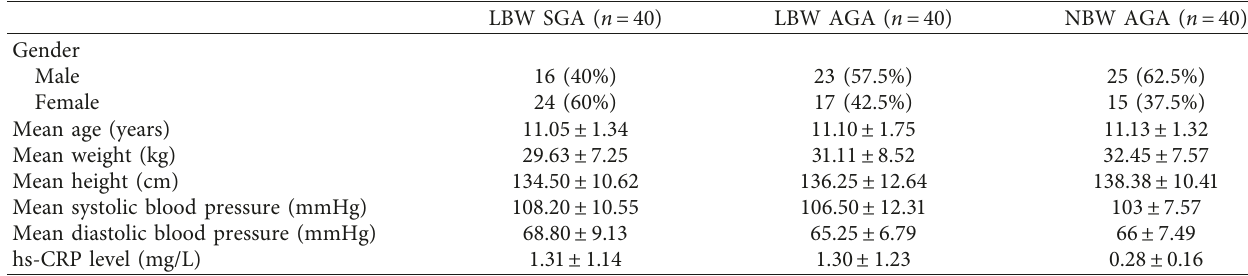
Table 1: Baseline characteristics of the study participants.